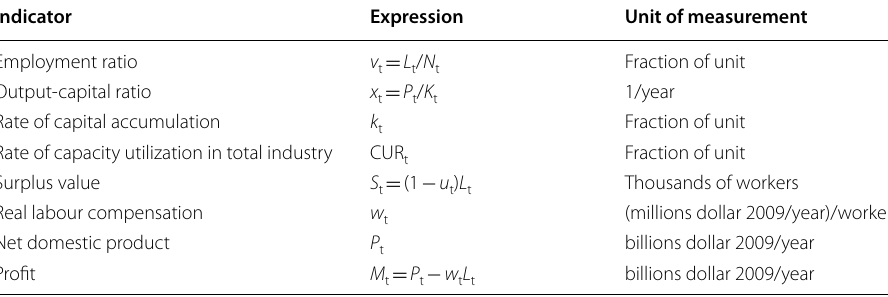
One billion is 10 9